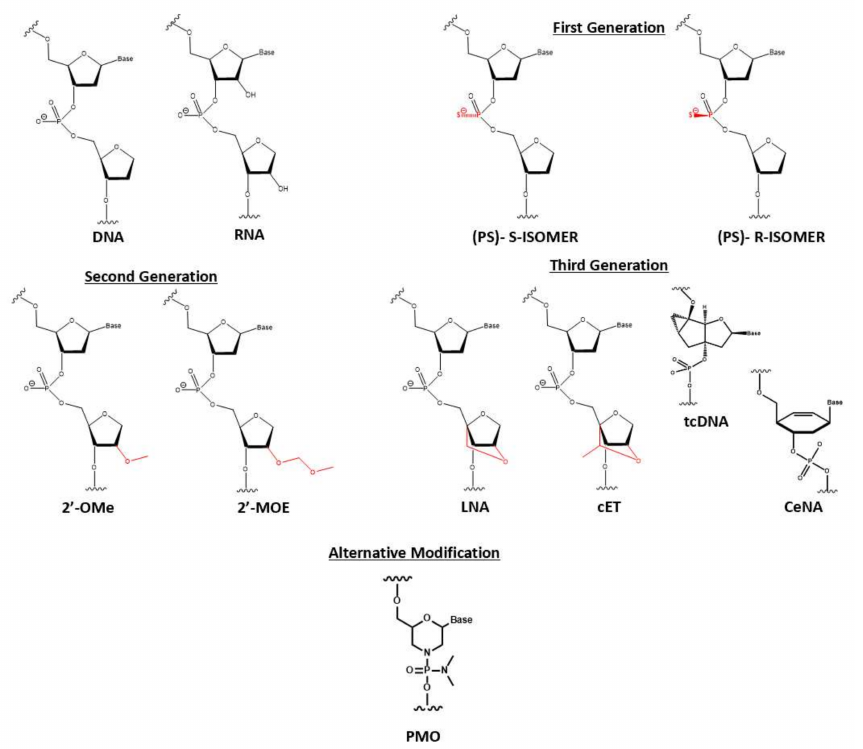
Figure 4. Three generations of common nucleic acid modifications. First generation replaced phospho- diester (PO) backbone to phosphorothioate (PS) to enhance degradative resistance. Second generation includes modification of 2 (cid:48) ribose into 2 (cid:48) -O-methyl (2 (cid:48) -OMe) and 2 (cid:48) -O-Methoxyethyl (2 (cid:48) -MOE), which are popular in gapmer synthesis. Third generation restricts conformational flexibility by introducing a methyl bridge between 2 (cid:48) -O and 4 (cid:48) of ribose. Locked nucleic acid (LNA) and constraint ethyl (cET). Ribose moiety would be completely replaced with tricyclic DNA (tcDNA) or cyclohexene (CeDNA). Alternative modification was phosphorodiamidate morpholino oligomer (PMO). This neutral nucleic acid was described with an additional amine accompanied with phosphorodiamidate